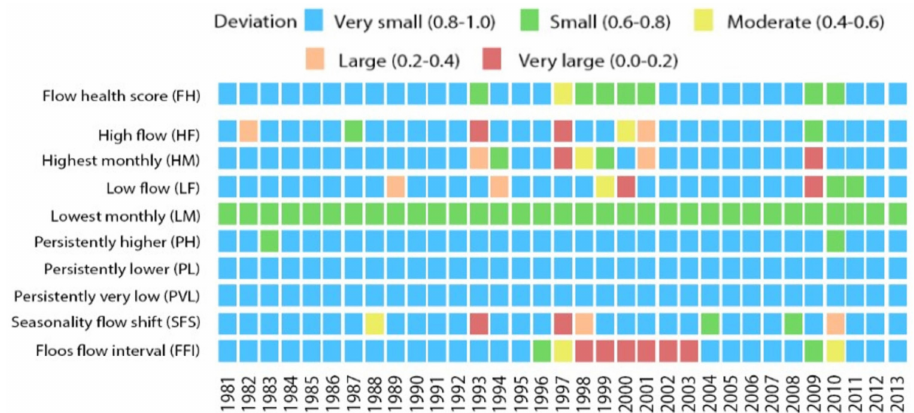
Figure 10. Graph of the mosaic to evaluate the health of “La Yerbabuena” stream.